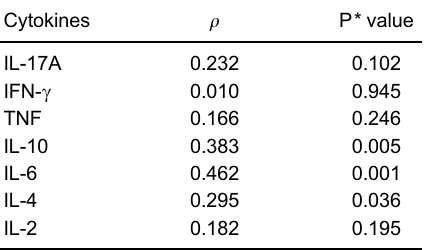
Table 4. Correlation of SLEDAI-2K score with cytokine levels in childhood-onset systemic lupus erythematosus patients.